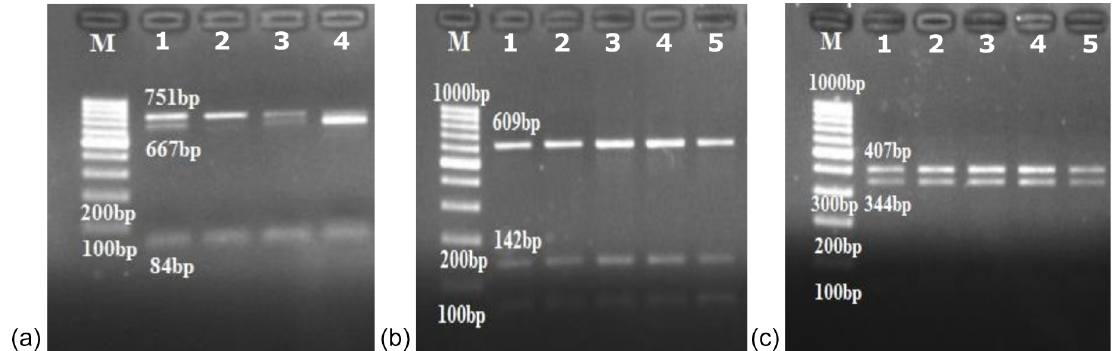
Figure 3. Eag I, Mbo I and Dra II restriction patterns of the LTF gene in Turkish donkey populations. (a) Eag I digestion of the LTF gene segment, lanes 1 and 3: AG heterozygotes (751; 667, 84bp); lane 2: AA homozygote (751bp); lane 4: GG homozygote (667, 84bp); (b) Mbo I digestion of the LTF gene segment (609, 142bp); (c) Dra II ( Eco 0109I) digestion of the LTF gene segment (407, 344bp); M – DNA size marker (Invitrogen ™ 100bp DNA ladder).